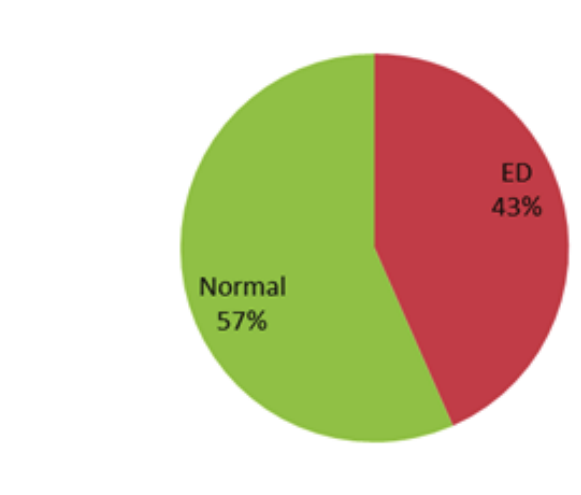
Figure 2: Frequency of ED after pelvic fracture among the studied patients.